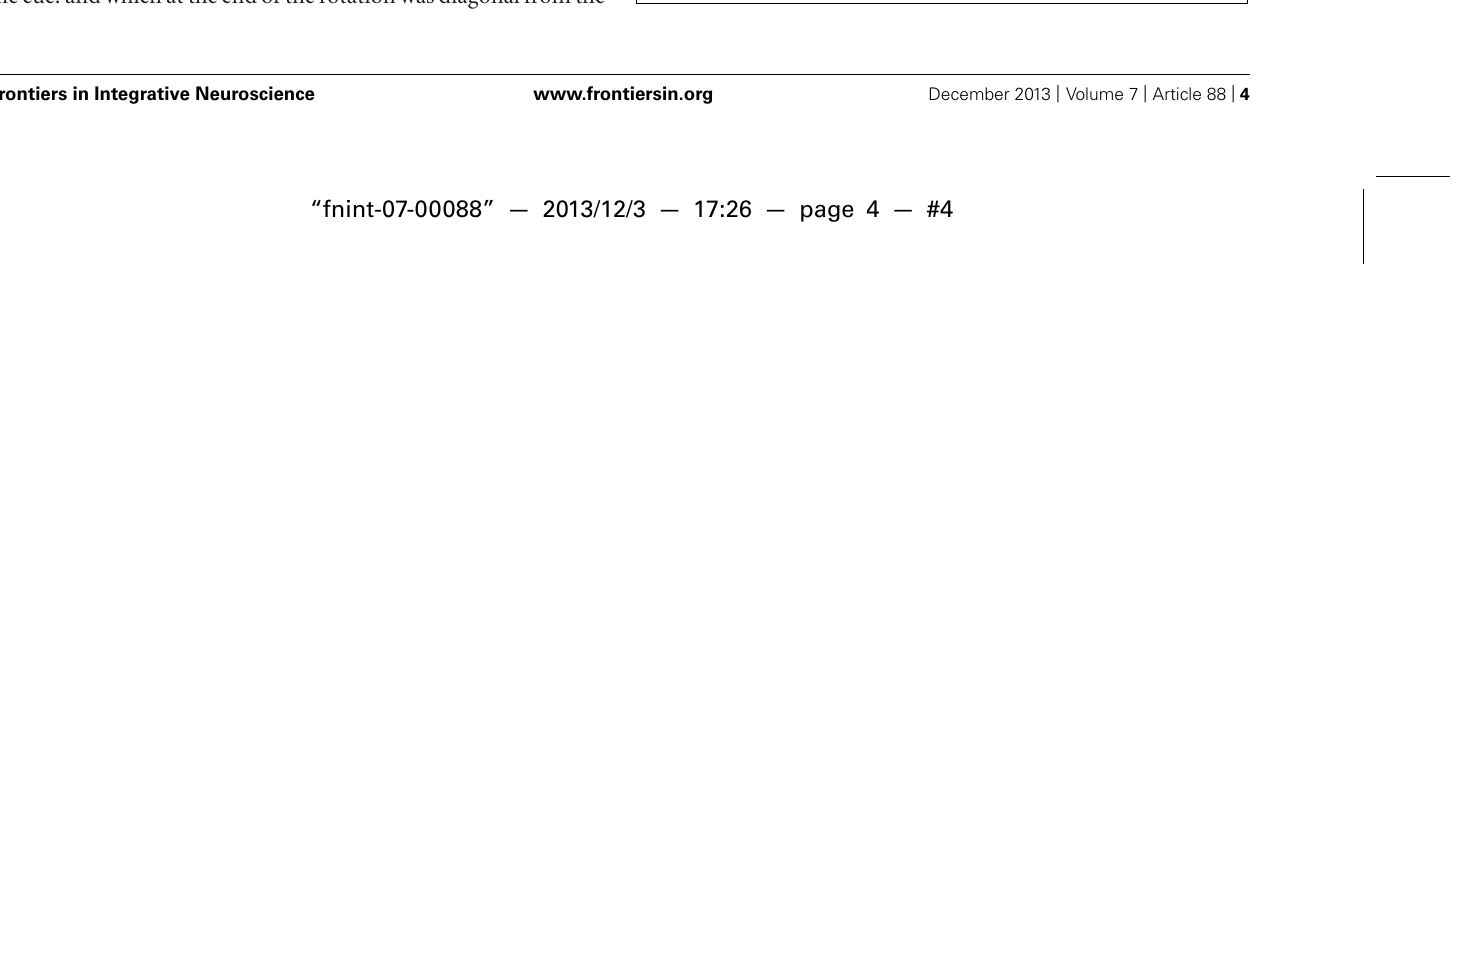
FIGURE 2 |Trial types of Experiment 1 – High Uncertainty condition. One rectangle was green (darker shade of grey in this grey scale depiction) and the other was yellow (light grey).Targets could appear in any of the four locations after a 180 ◦ rotation (either clockwise or counter-clockwise). Cued Space indicates the target appeared in the original spatial coordinates of the cue, SO indicates the target appeared in the opposite end of the cued object, DO indicates the target appeared in the non-cued object, and cued end indicates the target appeared in the portion of the object that was originally